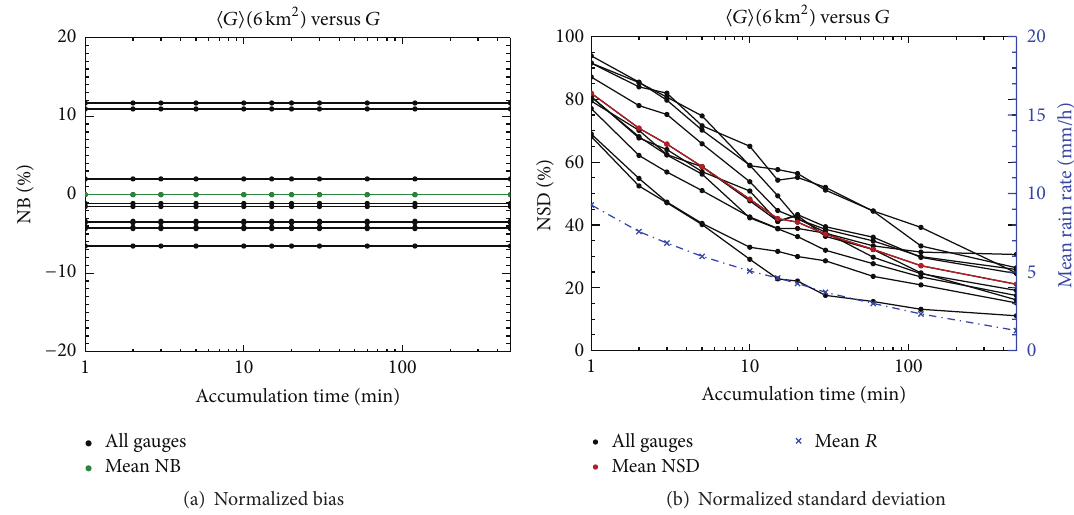
Figure 16: (a) The NB and (b) NSD between ⟨𝐺⟩(6 km 2 ) and 𝐺 from 10 rain gauges with accumulation time. ⟨𝐺⟩ is the temporally averaged ⟨𝐺⟩ with accumulation